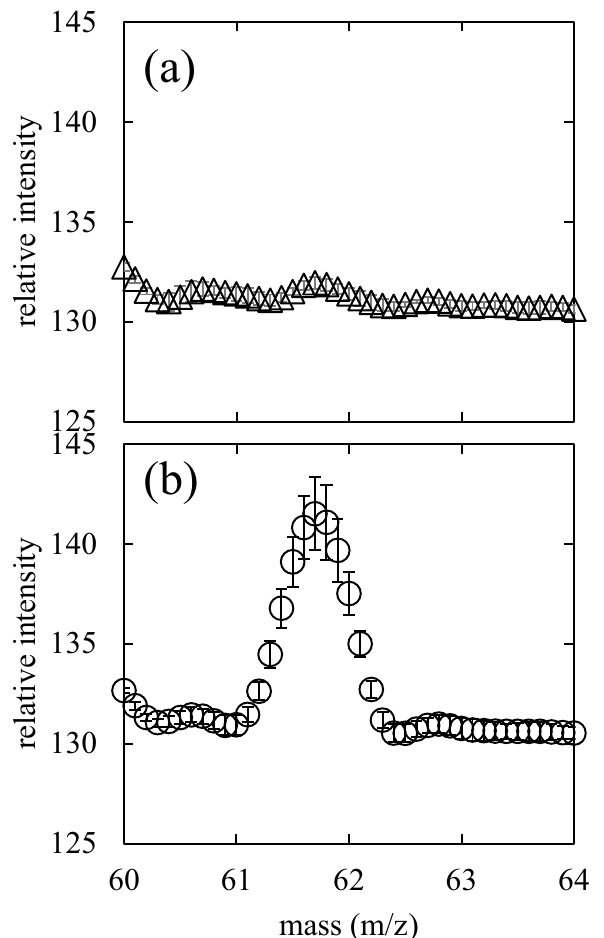
Figure 3. MS spectrum of 60–64 m/z of extract of 20 seeds ( a ) without plasma irradiation and ( b ) with 5 min plasma irradiation, obtained by QMS mode. Three shots were integrated. Marks and error bars show mean values and standard deviations of triplicate,